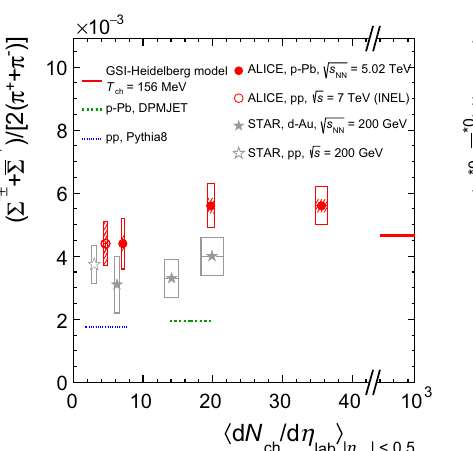
as total systematic uncertainties ( hollow boxes ) and systematic uncer- tainties uncorrelated across multiplicity ( shaded boxes ). A few model predictions are also shown as lines at their appropriate abscissa √ s NN , depending on the strangeness lisions at the same